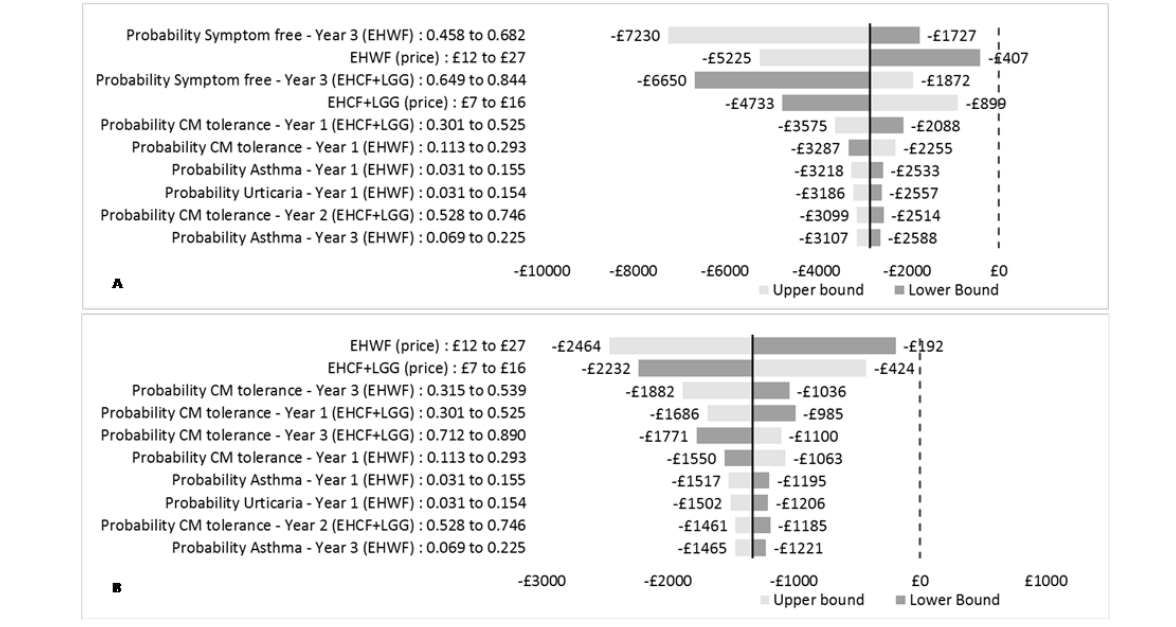
Figure 3. Tornado Diagrams for EHCF+LGG Versus EHWF